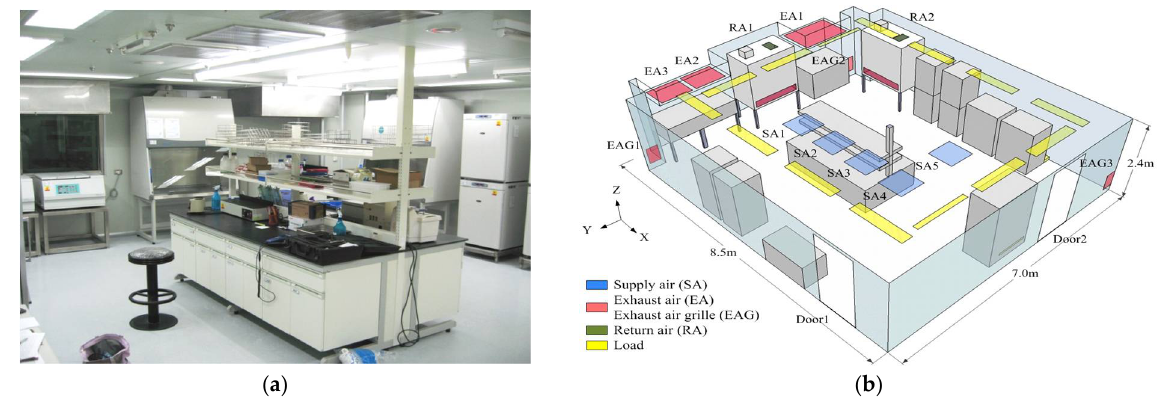
Figure 4. The investigated BSL-3 laboratory: ( a ) snapshot; ( b ) geometric model.